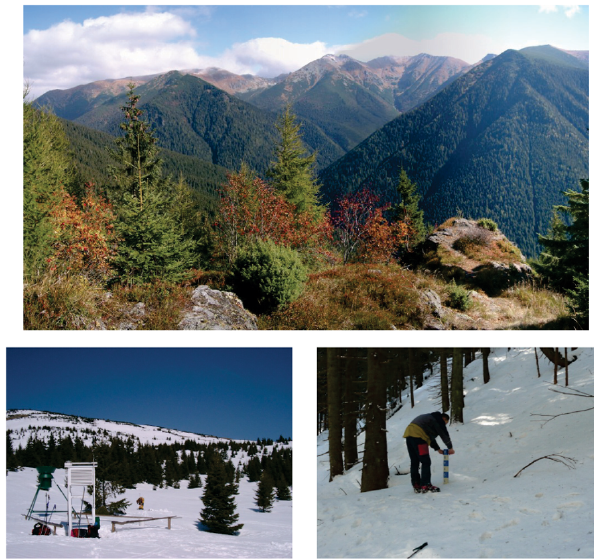
Fig. 1. View to the highest part of the Jaloveck´y creek catch- ment (upper panel), climate station and snow course locations at ˇCervenec (bottom left panel) and snow measurement in the forest (bottom right